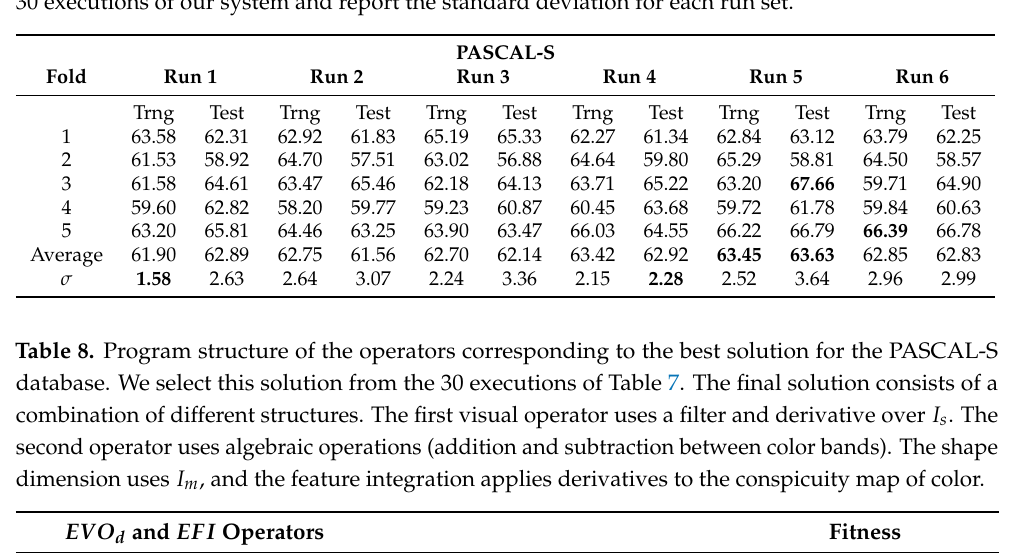
Table 7. Performance of the best individuals of the GBVSBP model for all PASCAL-S database runs. Each pair of training and testing corresponds to one experiment of the k-fold. Therefore, we obtain 30 executions of our system and report the standard deviation for each run set.